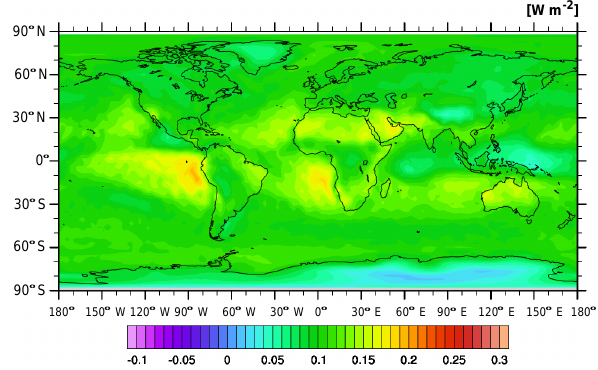
Figure 6. Geographical distribution of the annual mean net instan- taneous radiative forcing at TOA for a homogeneous 1% contrail